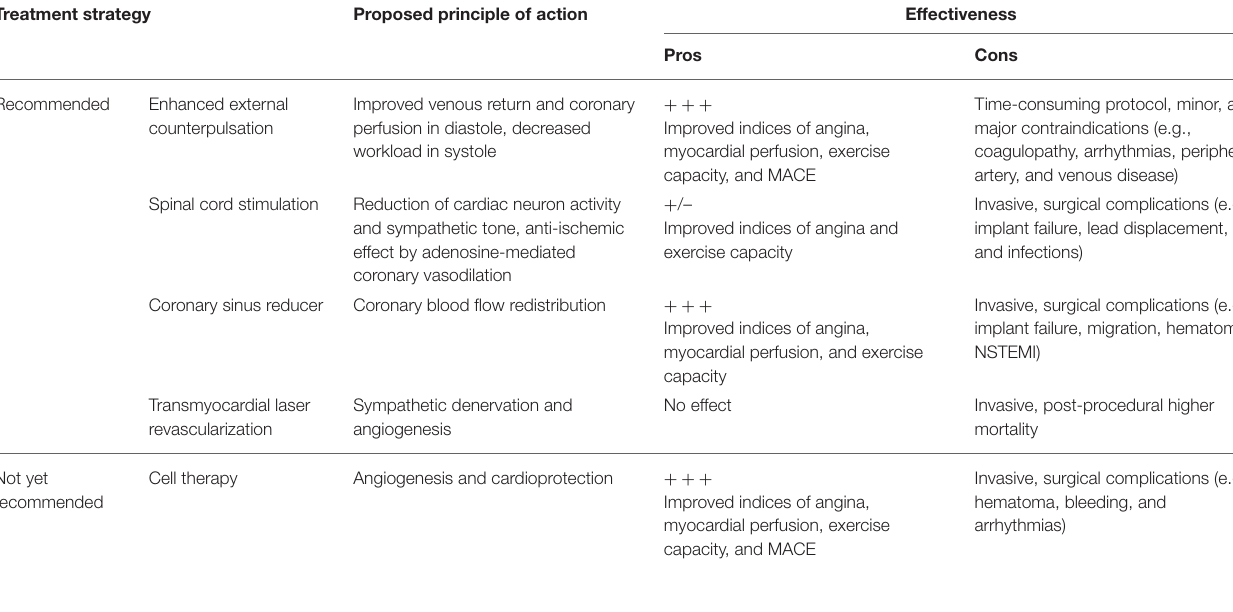
TABLE 2 | Non-pharmacological treatment options in the 2019 ESC and 2012–2014 ACC/AHA guidelines for refractory angina vs. cell therapy. Treatment